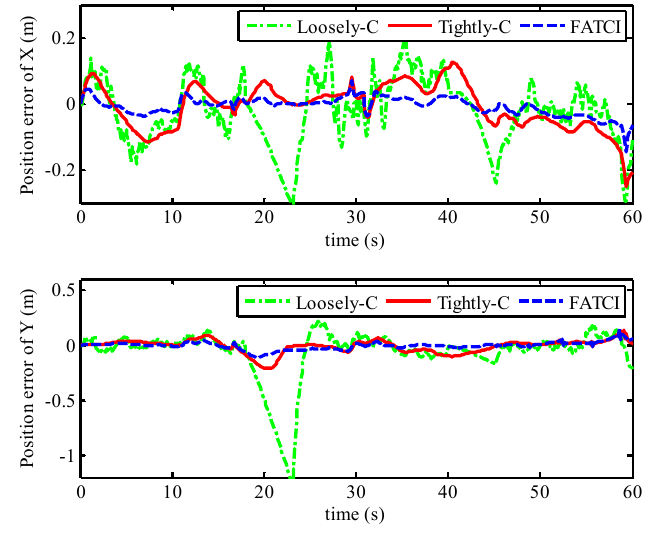
Figure 15. Position error with different integrated methods based on WSN short-term failure.